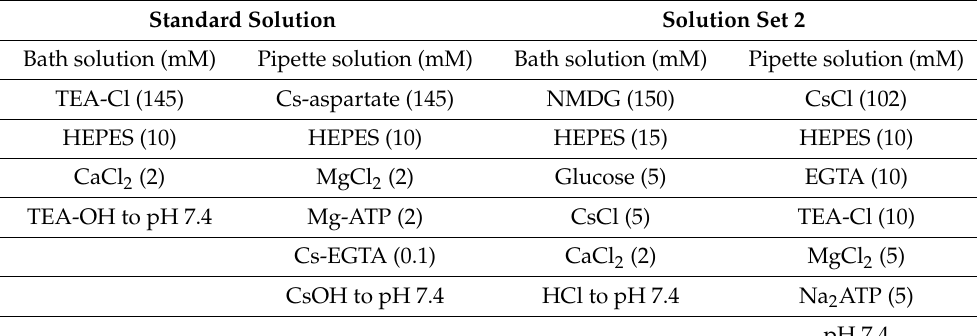
Table 1. Composition of the recording